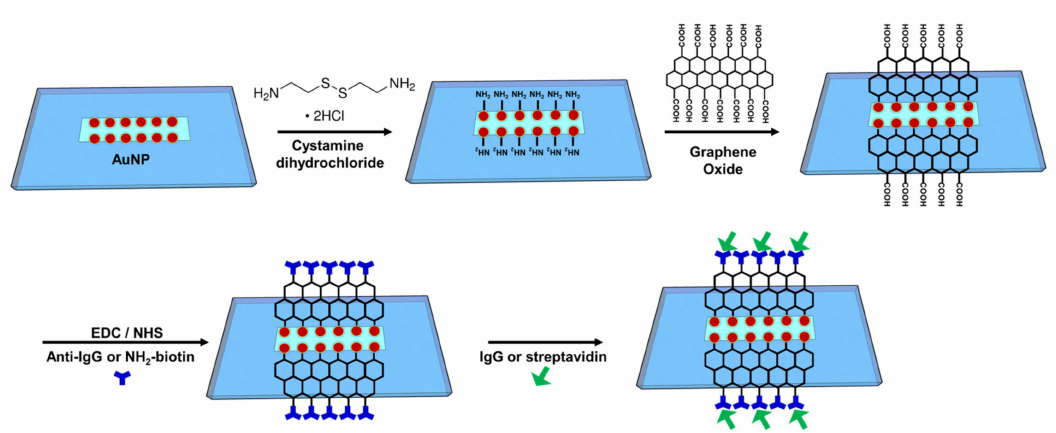
Figure 1. Schematic representation of the AuNP-cystamine-GO-anti-IgG and AuNP-cystamine- GO-NH 2 -biotin functionalization setup in the GO-OW sensor chip. EDC: 1-ethyl-3- (3-dimethylaminopropyl) carbodiimide hydrochloride; NHS: N